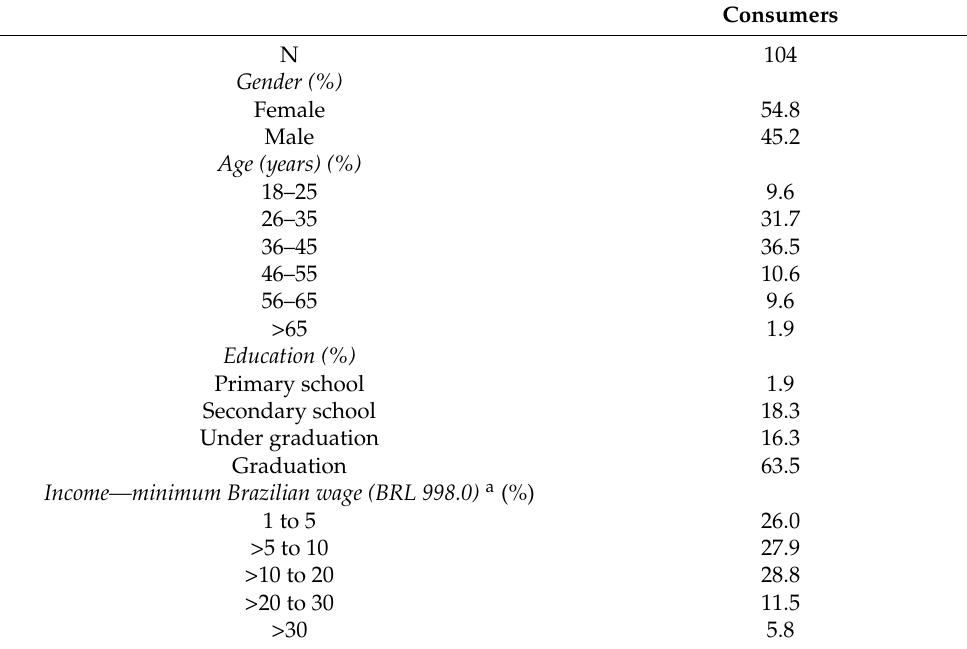
Table 1. Socioeconomic information of the consumers (n =